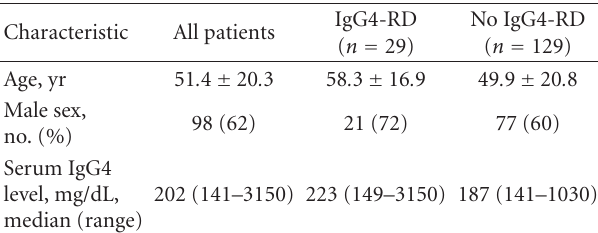
Table 1: Demographics and serum IgG4 levels ( n = 158).